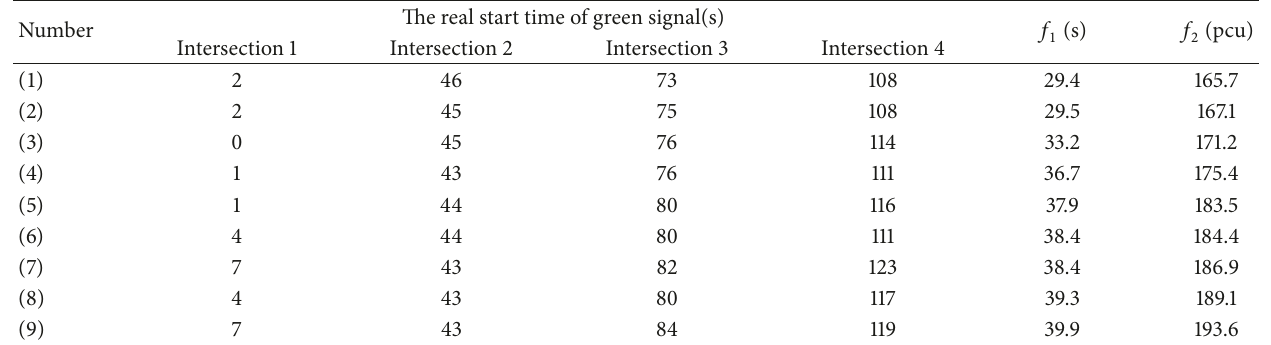
Table 3: The Pareto solution set for an increasing arrival rate when 𝑡 0 is 9 o’clock.